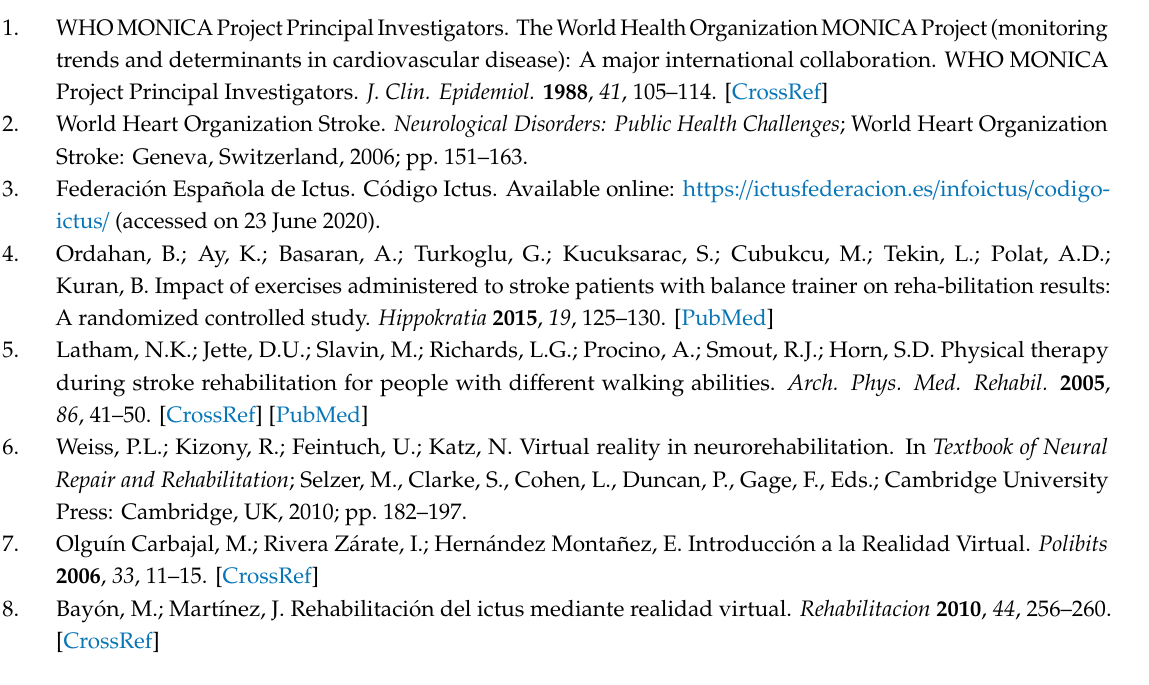
Table S1: Comprehensive description of the articles included in the systematic